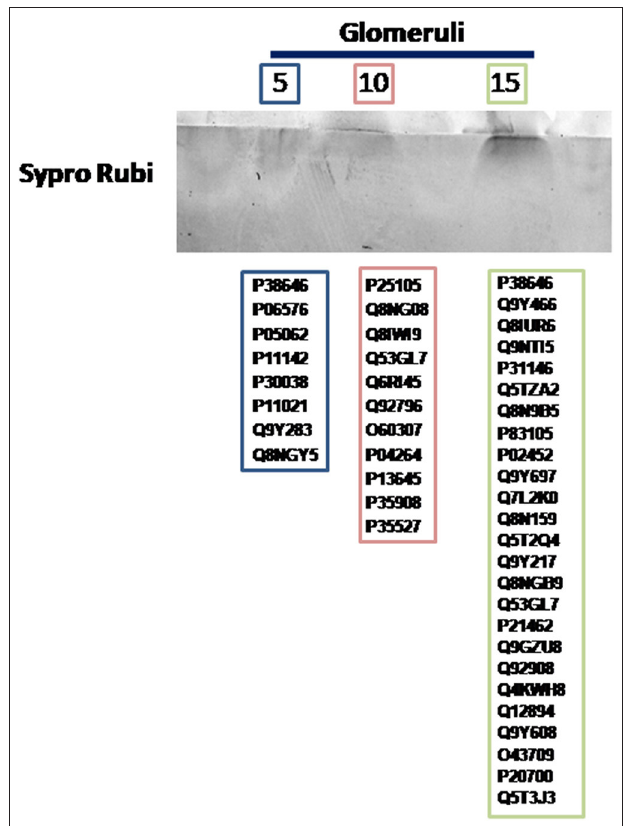
FIGURE 12 | Proteins identified after the application of the optimizated conditions in the present work to the treatment of 5, 10, or 15 microdisected